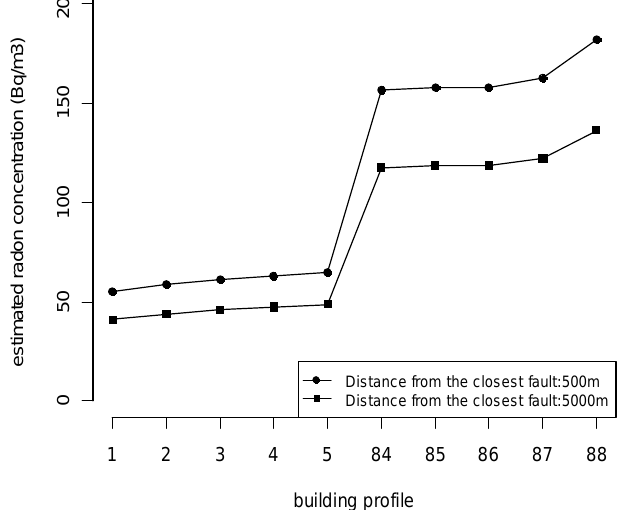
Figure 10. Building profiles with the lowest and highest estimated